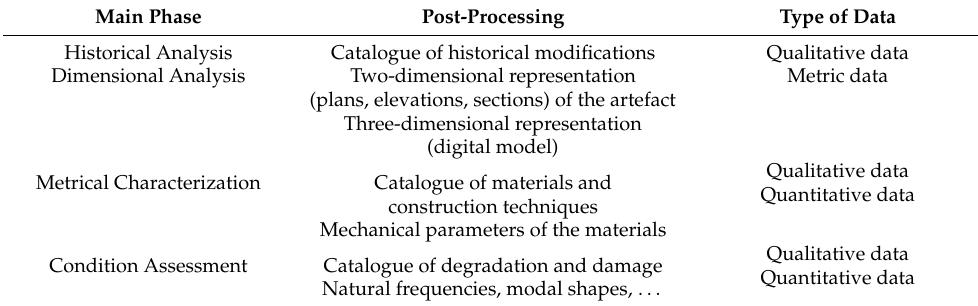
Table 1. Data acquired from interdisciplinary